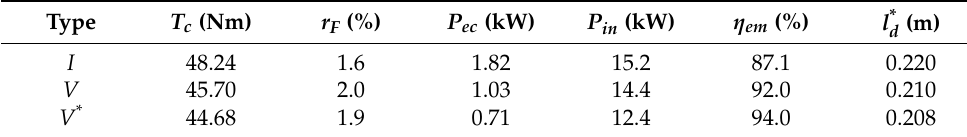
Table 7. Data comparison between the MRSP types.